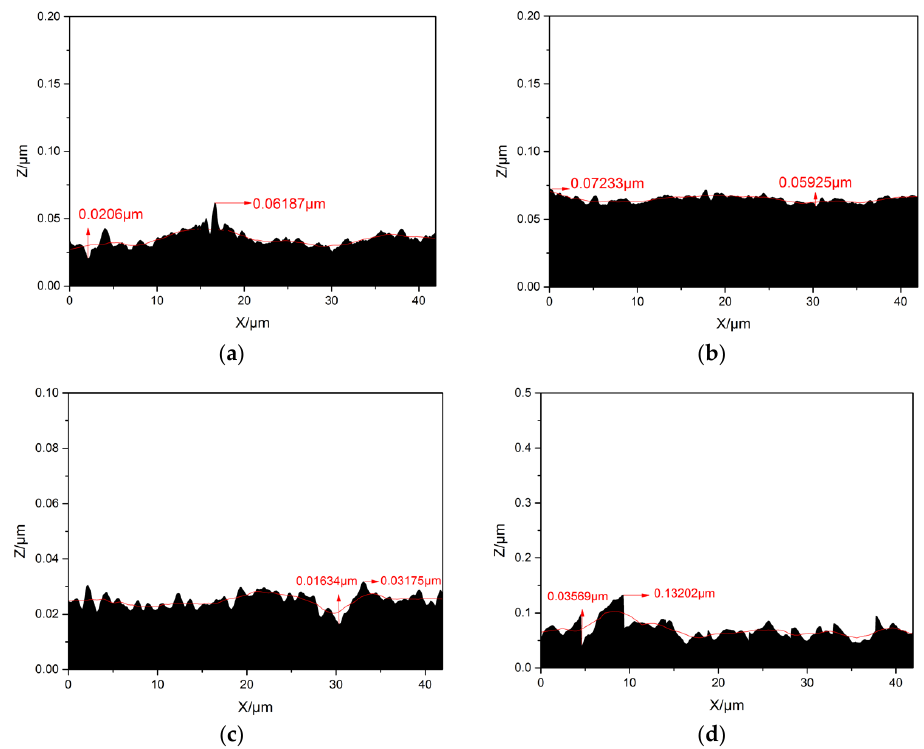
Figure 8. Optimal surface morphology for each sample. ( a ) sample 1; ( b ) sample 2; ( c ) sample 3; and ( d ) sample 4.